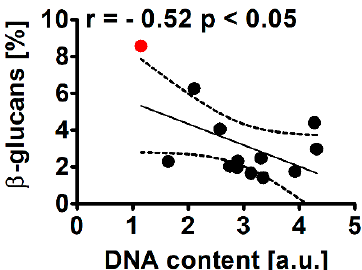
Figure 4. Colchicine and cytochalasin B-mediated effect on the levels of β -glucans in the microalga Planktochlorella nurekis . Correlation analysis between β -glucans and DNA content. Twelve CC-treated clones were considered (black dots). WT cells are denoted as a red dot. Results represent the mean from three independent experiments. The 95% confidence interval is shown. Correlation analysis of the data was performed using a Linear Correlation (Pearson r) test.